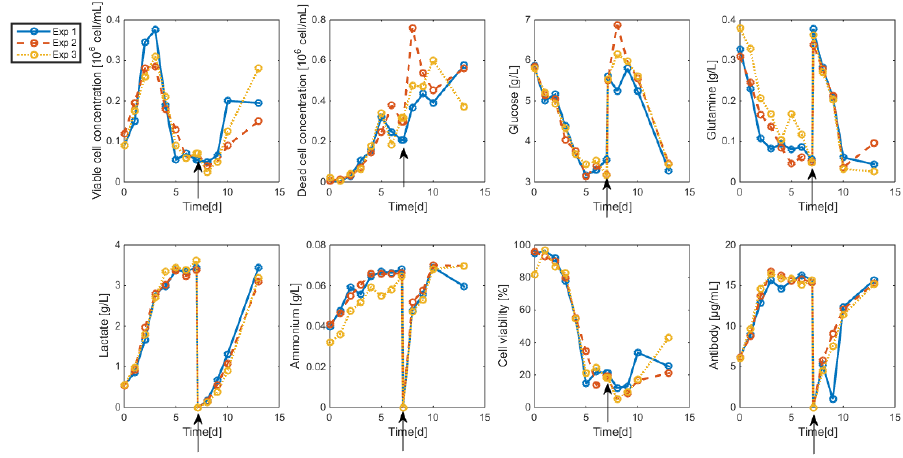
Figure 3. HB2 sequential batch culture data sets. Medium refreshment times are indicated by the arrows. the